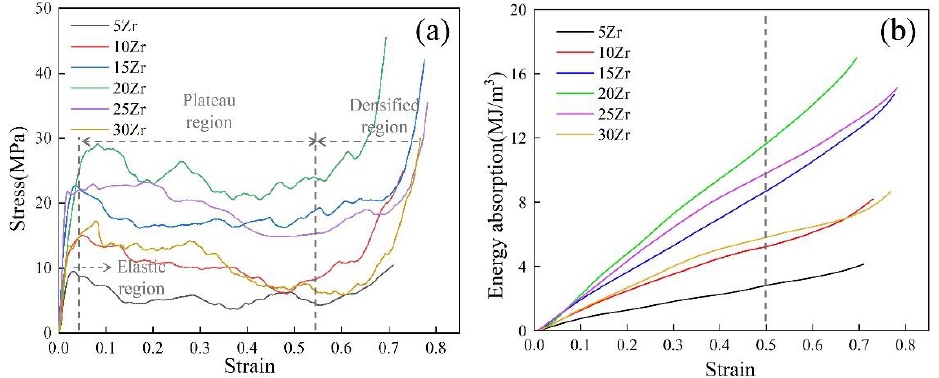
Figure 8. ( a ) Compressive stress – strain and ( b ) energy absorption capacity curves of composite materials with different Zr contents.